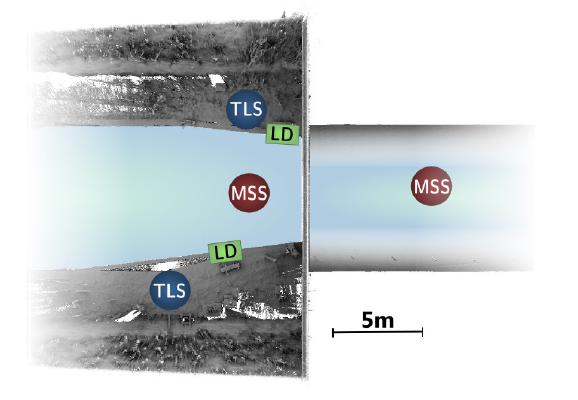
Figure 3: Illustration of the acquisition setup seen from above, featuring TLS and MSS stations, as well as the location of ladders (LD)